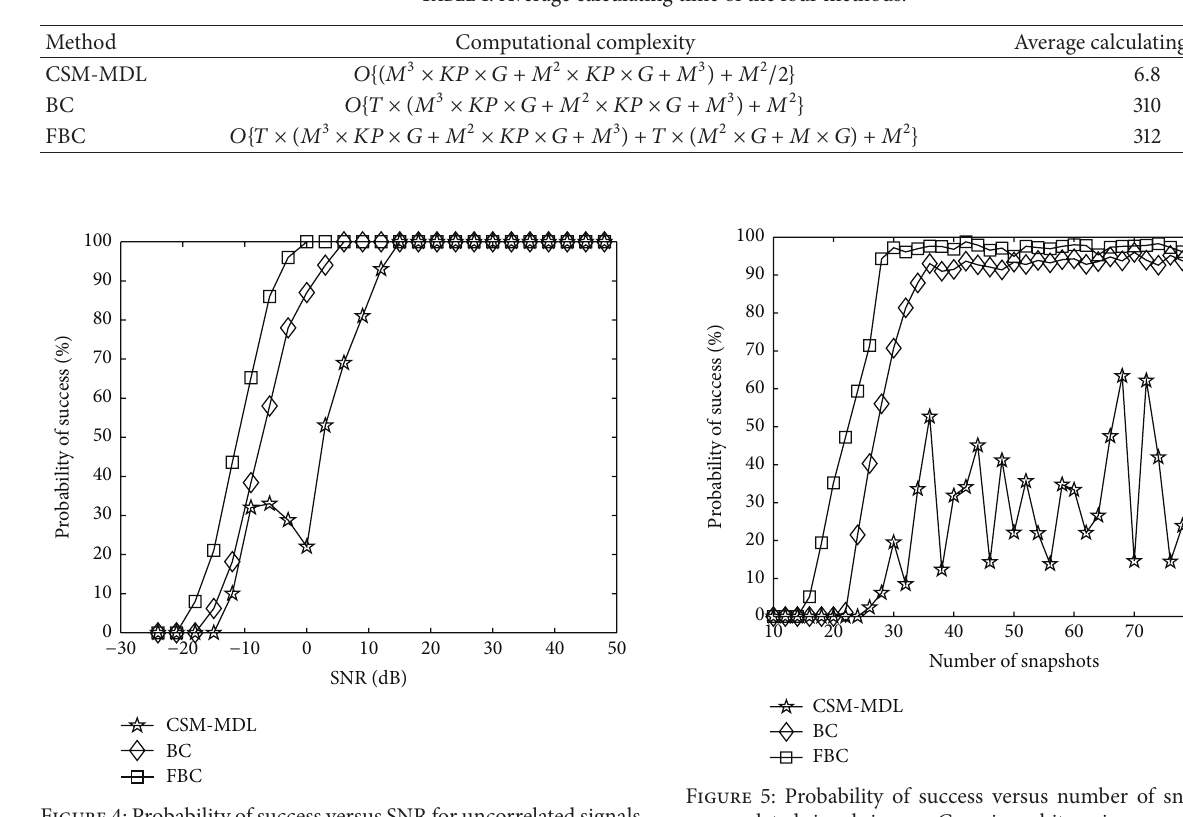
Figure 4: Probability of success versus SNR for uncorrelated signals in non-Gaussian white noise.